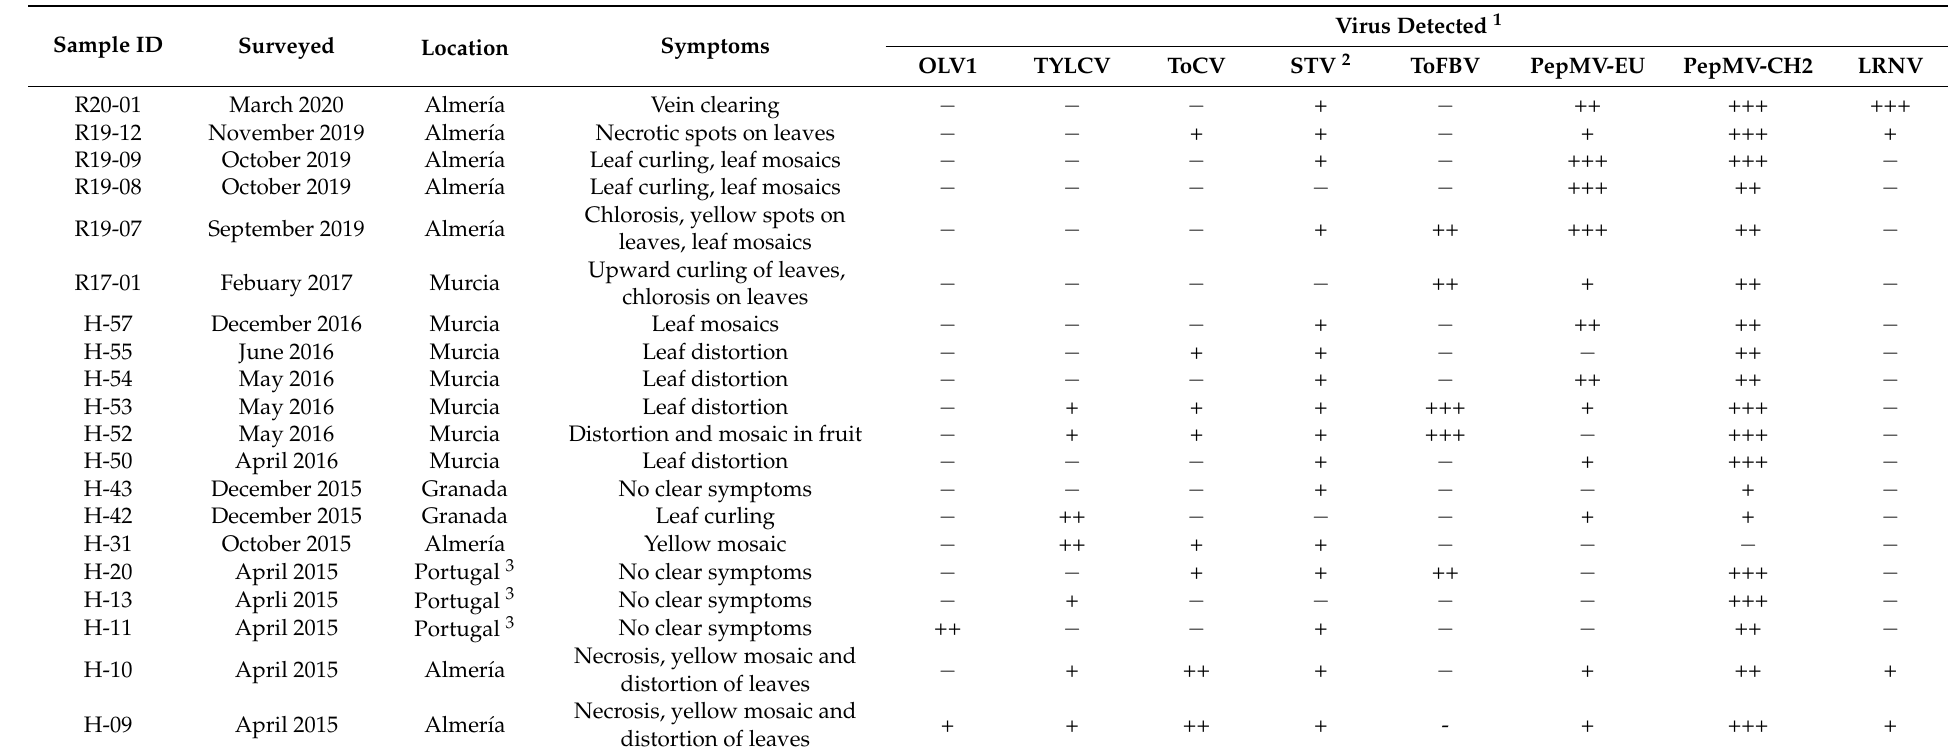
Table 1. Description of samples and confirmation of viral infections by means of qRT-PCR or conventional